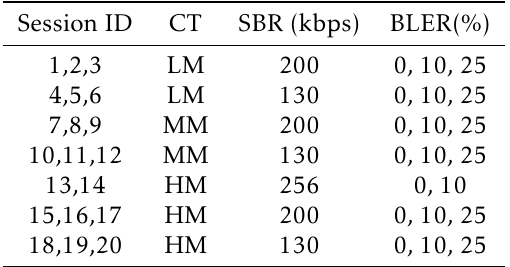
Figure 7. Genetic algorithm based adaptation logic. Table 7. Initial service and radio access conditions.